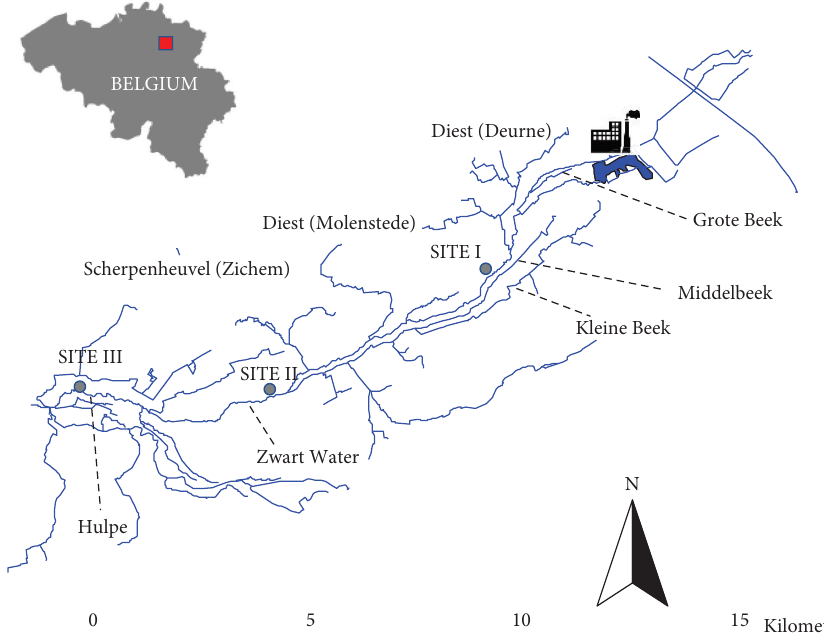
Figure 1: Location of the sampling sites along the Winterbeek (Site I: Grote Beek; Site II: Zwart water; Site III: Hulpe